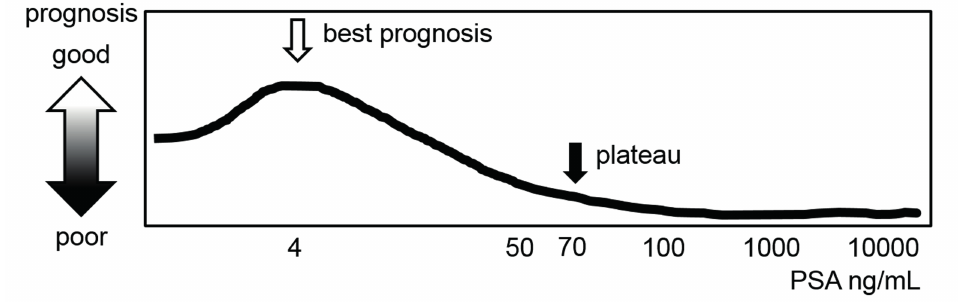
Figure 3 - Schematic model of prognosis of patients with Pca based on initial PSA level.